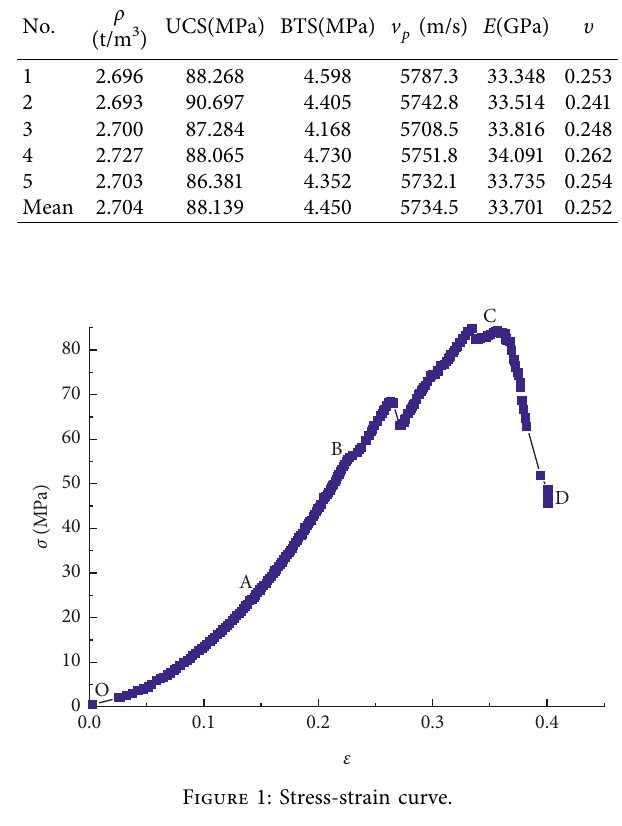
Figure 1: Stress-strain